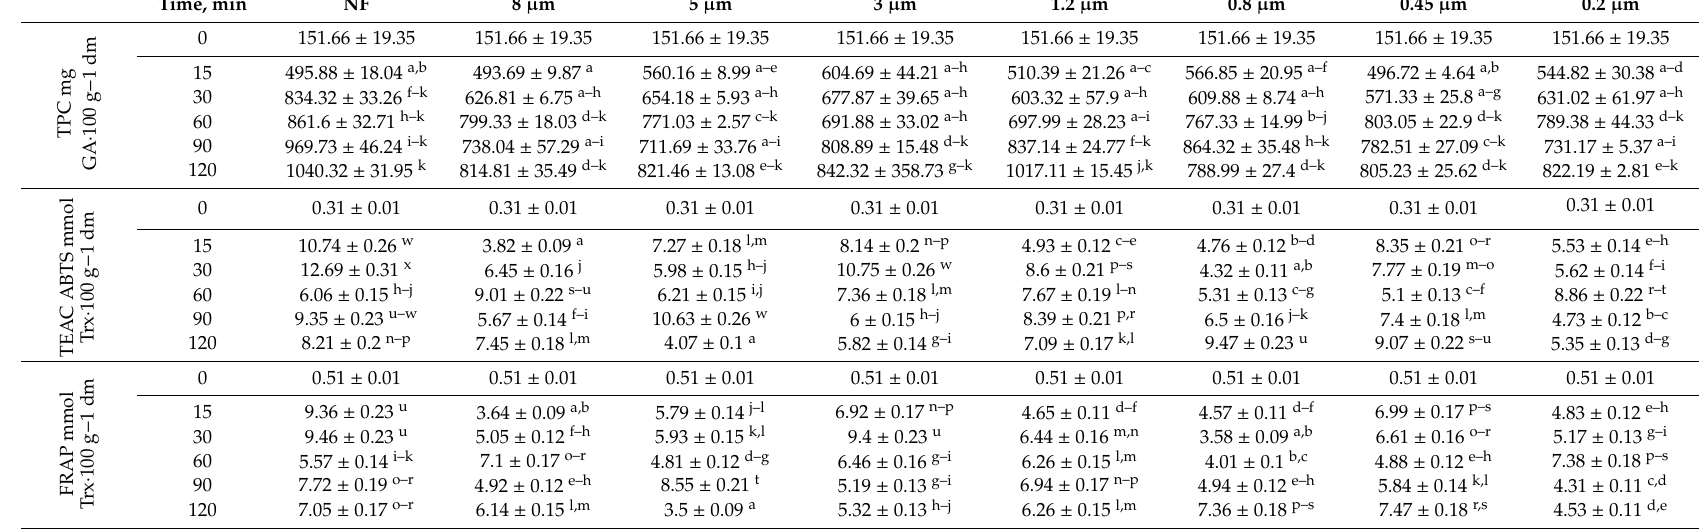
Table 3. Total polyphenolics content (TPC) and antioxidant capacity measured by TEAC ABTS and FRAP of pumpkin slices dehydrated in filtrated and non-filtrated chokeberry